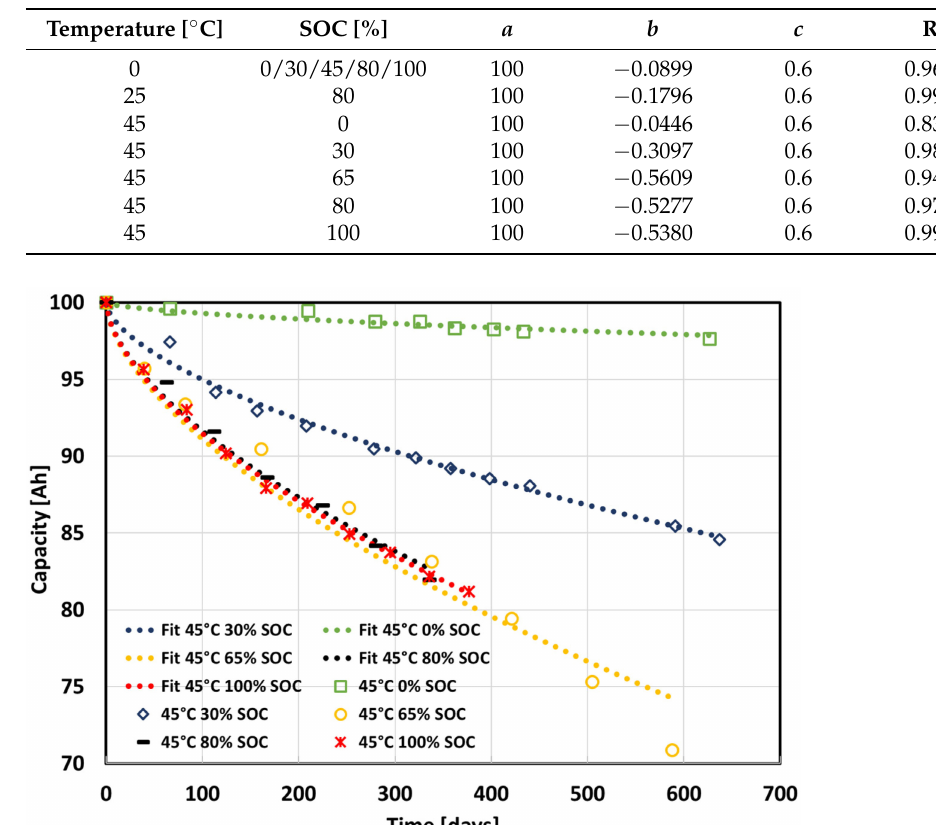
Figure 16. Calendar ageing data and curve fitting at 45 ◦ C and different SOC levels [51].